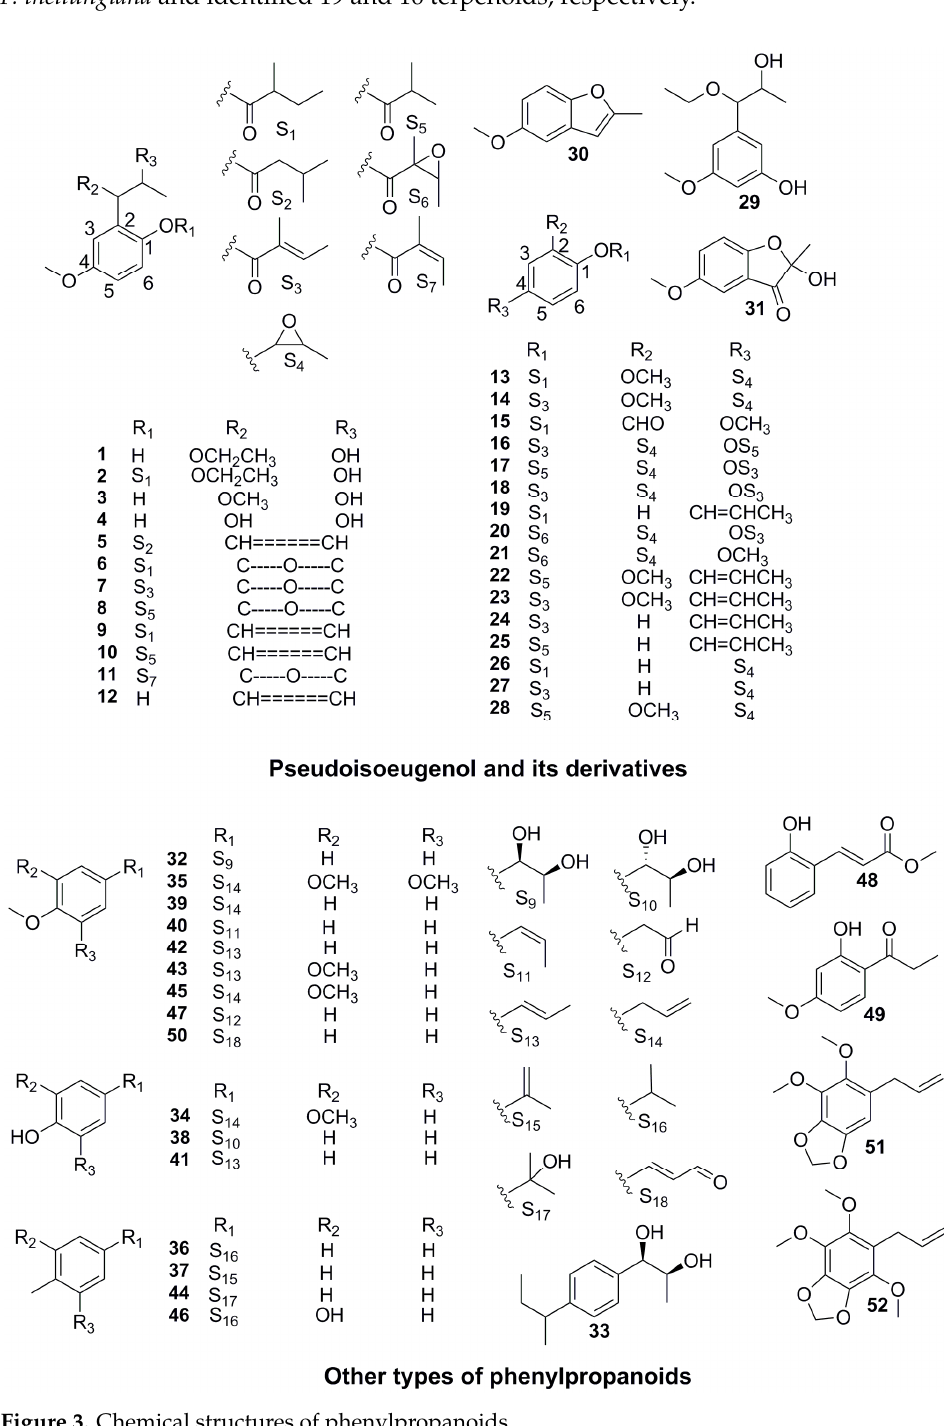
Figure 3. Chemical structures of phenylpropanoids.